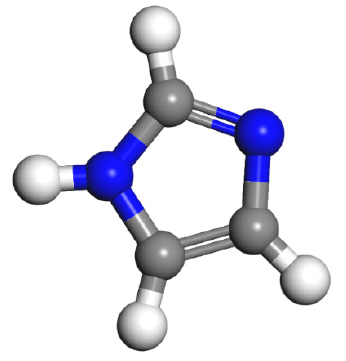
Figure 4. The model of MC120D (colour legend: hydrogen H (white); nitrogen N (blue); carbon C (grey)).